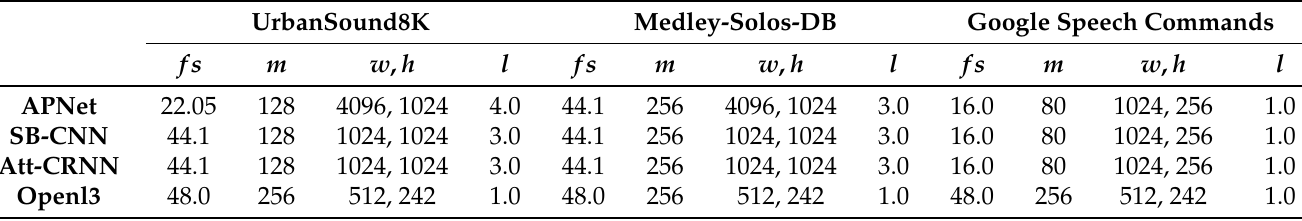
Table 1. Mel-spectrogram parameters for each model and dataset: sampling rate in kHz ( f s ); window length ( w ) and hop size in samples ( h ); number of mel-bands ( m ); and, audio slice length in seconds ( l